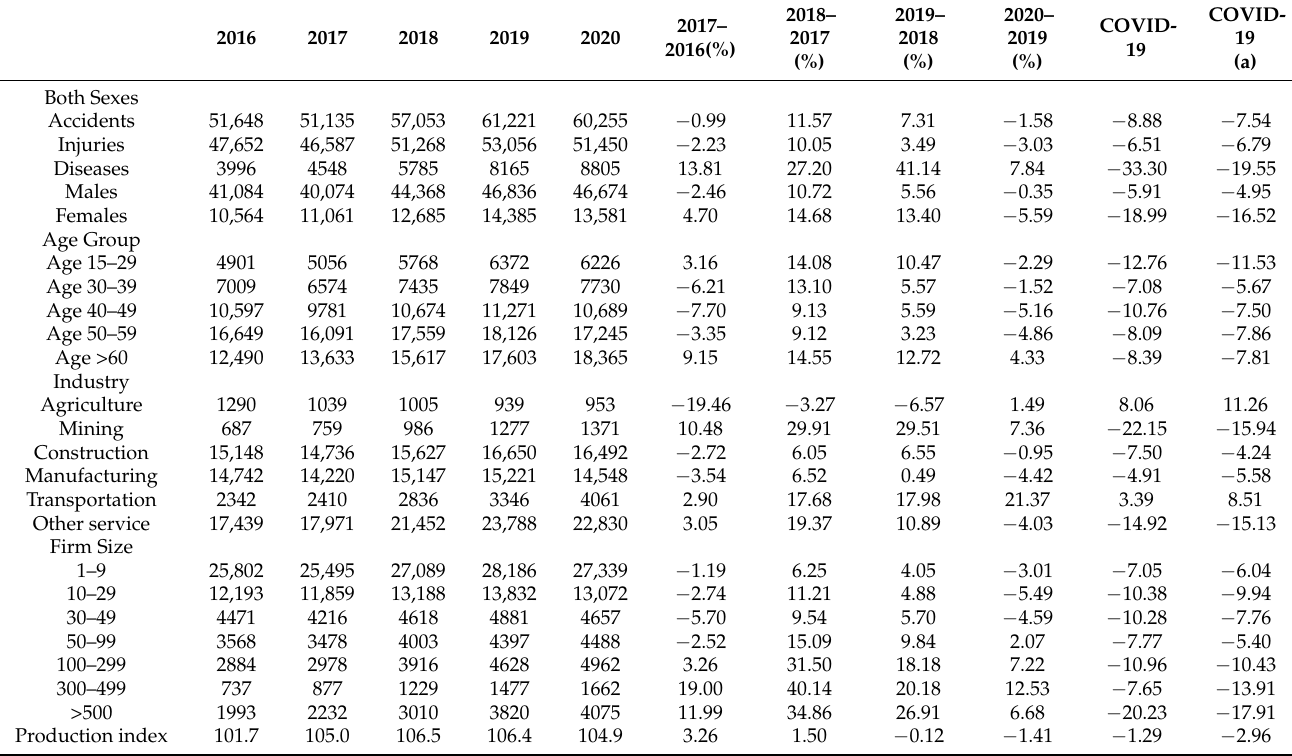
Table 1. Basic statistics of workplace accidents in Korea (February–August